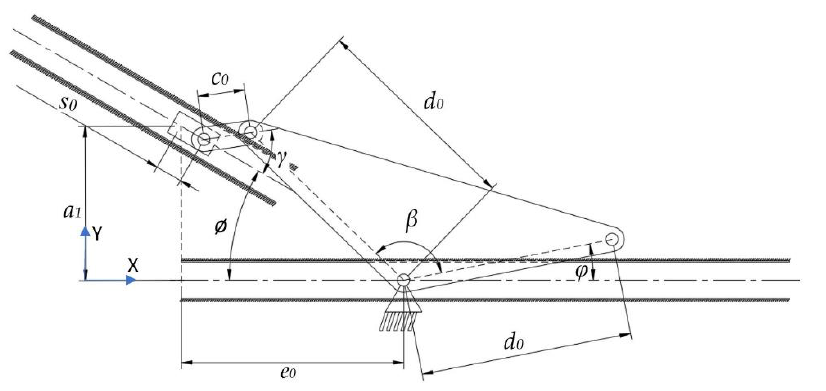
Figure 10. The combined structure of the oral jaw.